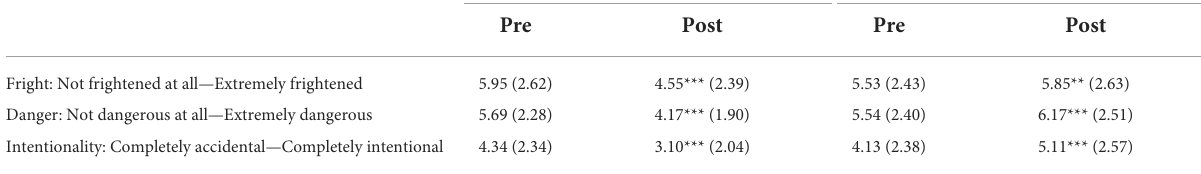
TABLE 2 Individual measures of fright, danger, and shark bite intentionality, and associated pre and post treatment mean and standard deviation response values, and paired t -test results. Measures a Mean response (positive